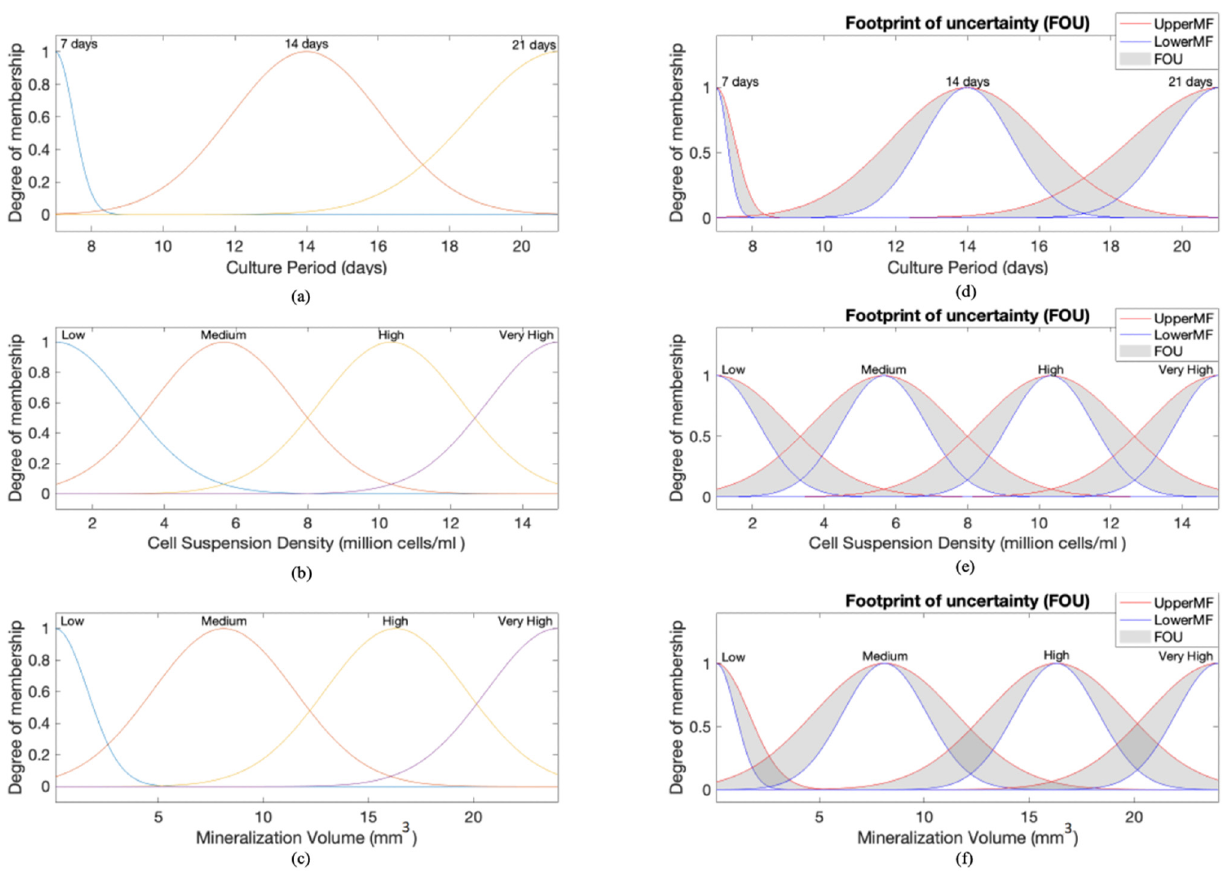
7 Table 2. Gaussian membership functions range [Sigma, Mean]. Linguistic Variable Culture Period (Days)